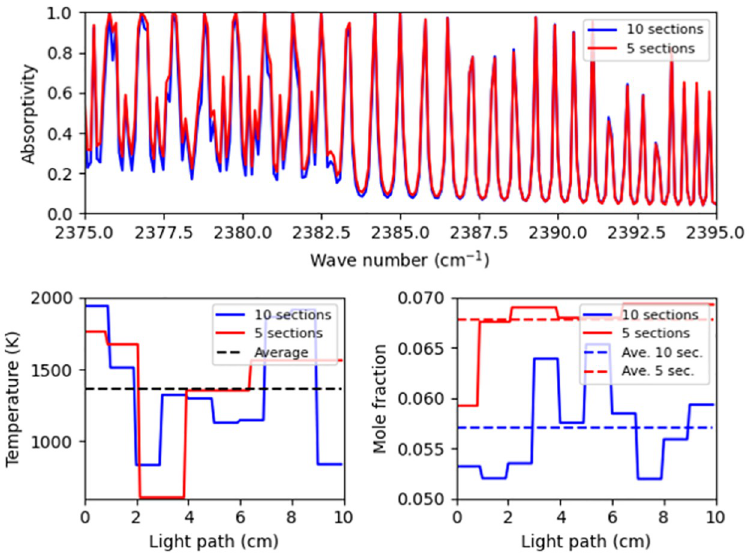
Fig 9. A showcase of ten-section-profile spectrum, compared with five-section profile spectrum of same average temperature. In the figure, the top, bottom left and bottom right subplots represent the spectral profile, the temperature profile and the concentration profile,